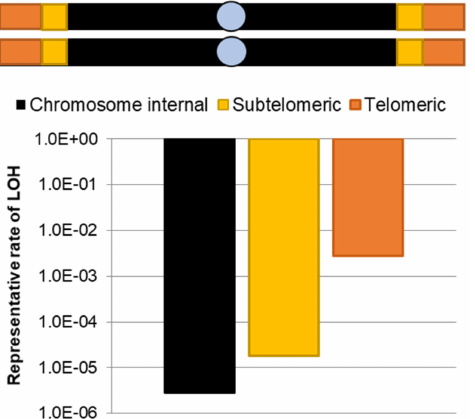
Figure 3. Rates of loss of heterozygosity (LOH) increase towards chromosome ends. An average LOH rate for each genomic region is depicted for chromosome internal sequences (black), the subtelomeres (yellow), and telomeres (orange) based on published (chromosome internal and subtelomeric) [28,56] and unpublished results (telomeric). All data is derived from LOH assays in which a URA3 marker was inserted within di ff erent genomic regions and its location determined by either sequencing or contour clamped homogenous electric field (CHEF) gel analysis and Southern blotting. Centromeres are indicated by grey